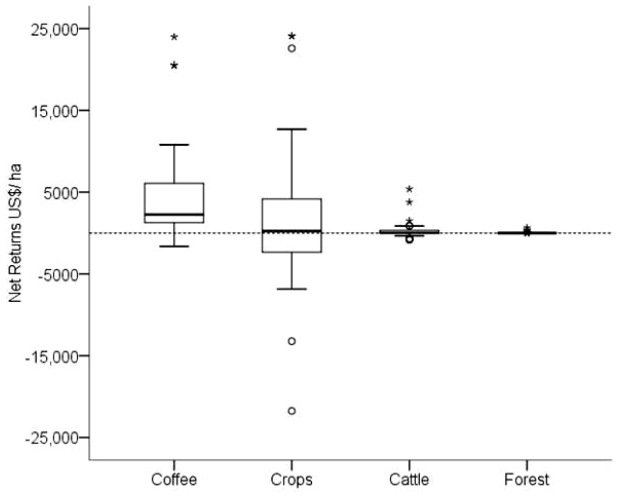
Fig. 2 . Net returns in US$ ha-1 for each productive land use for 2010-2011. The dotted line represents zero; circles = values beyond the extents of the second quartile; stars = extreme values beyond the first and third quartiles; bold lines = median; forest N = 52, mean = US$35, median = 0; cattle N = 48, mean = US$282, median = US$44; crops N = 58, mean = US$1501, median = US$261;, and coffee N = 28, mean = US$5710 and median =